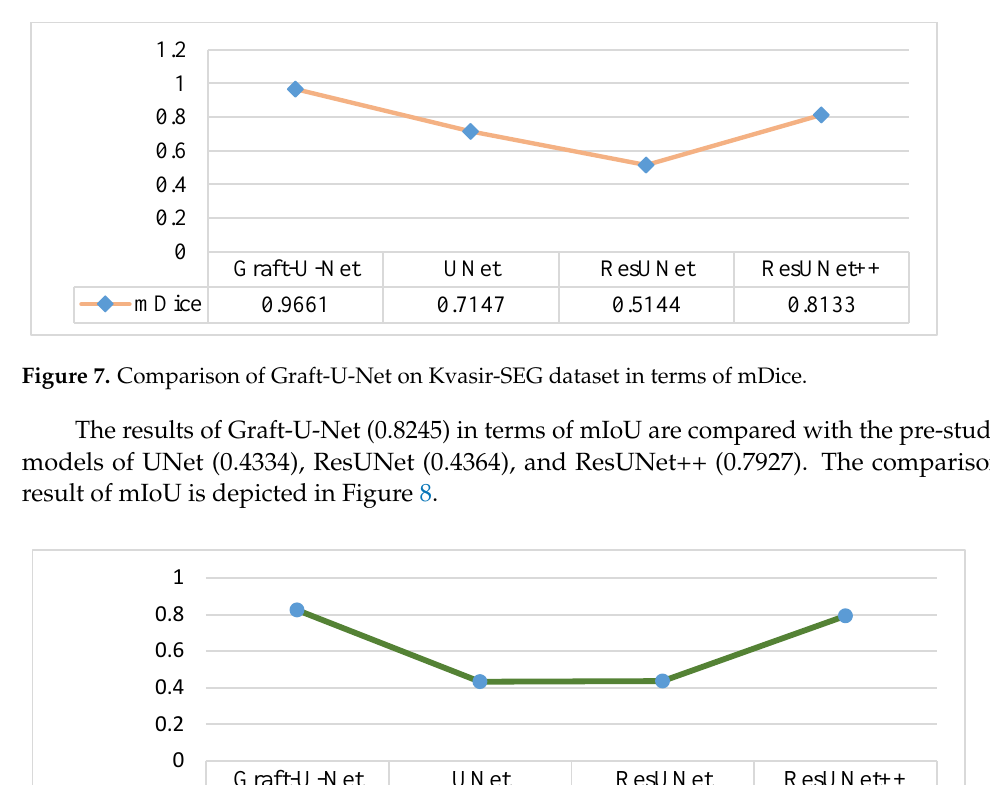
Figure 6. Results of Graft-U-Net with Kvasir-SEG dataset. The results of Graft-U-Net (0.9661) in terms of mDice are compared with the pre-study models of UNet (0.7147), ResUNet (0.5144), and ResUNet++ (0.8133). The analysis declares that the suggested model performs better in terms of mDice when using the Kvasir-SEG dataset. The Graft-U-Net architecture performs marginally well against the baseline architecture. The outcome of mDice on the Kvasir-SEG dataset is shown in Figure 7.